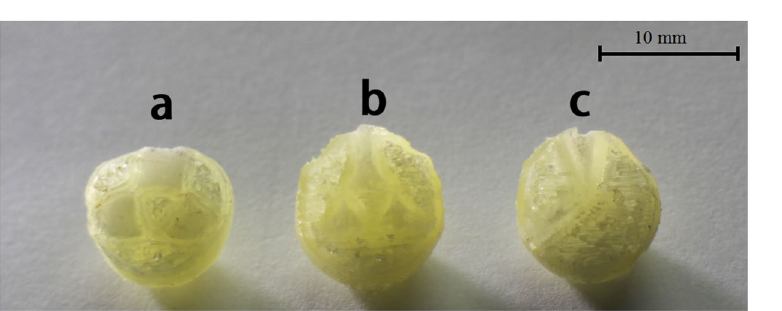
Figure 1. Three kinds of models of tablet kernels with different shapes. ( a ) The first model has four cylinder cavities placed in a sphere (Cylinder model). ( b ) The second model has four horn cavities placed in a sphere (Horn model). ( c ) The third model has four reversed horn cavities placed in a sphere (R-Horn model). The blue part represents the exposed area of the drug kernel. Along with the decrease of height, the surface area ( S ) will change in three kinds of models.